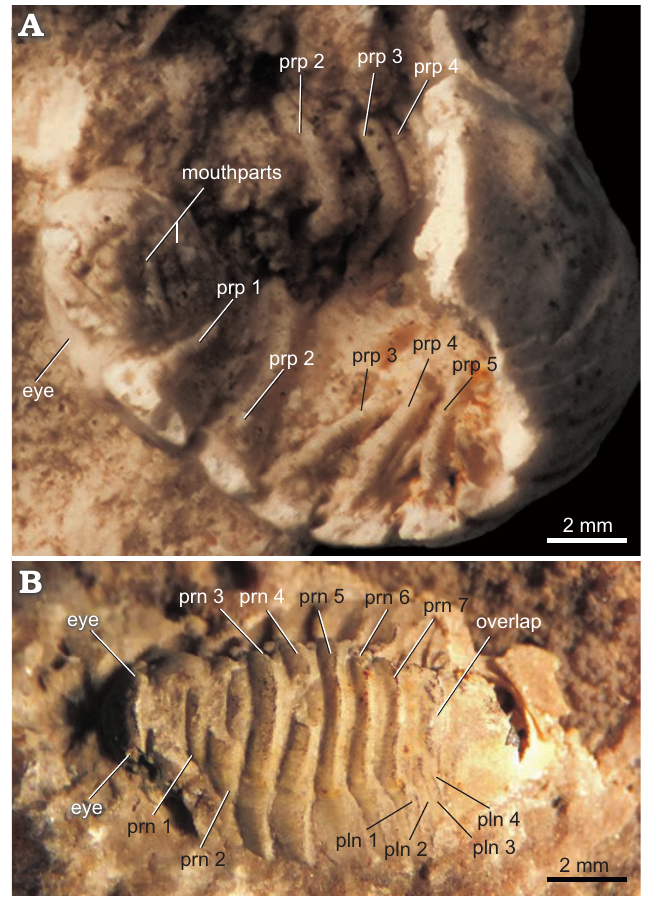
Fig. 3. Appendage views of isopod Heterosphaeroma priscum (Milne- Edwards, 1868), late Thanetian of Sézanne, Marne, France. A . SU.PAL.2017. 0.2.12 (plaster cast). B . SU.PAL.2017.0.2.3.2-2. Abbreviations: pln, pleo- nite; prn, pereonite; prp, pereopod. Photographs RV and Rémi Brageu